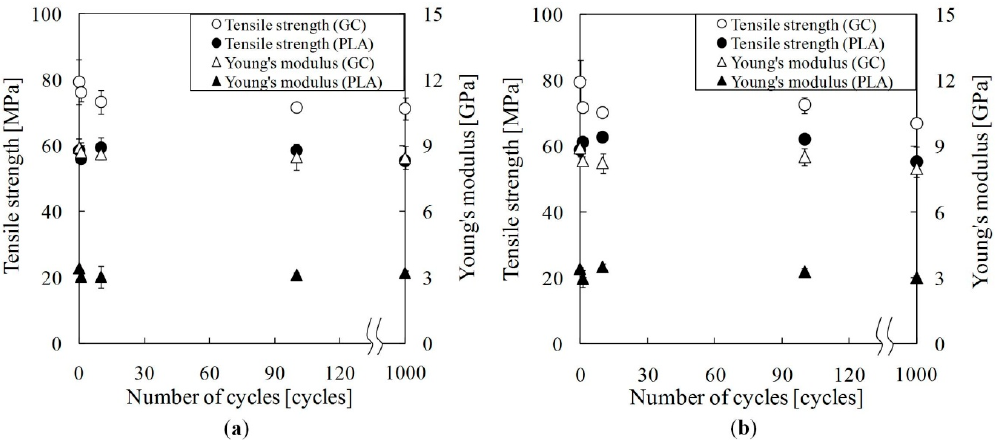
Figure 5. Tensile properties of green composite and PLA during thermal cycling: ( a ) 35–45 °C; ( b ) 35–55 °C. Table 1. Tensile test results of green composite and PLA (AVG: average value, SD: standard division).